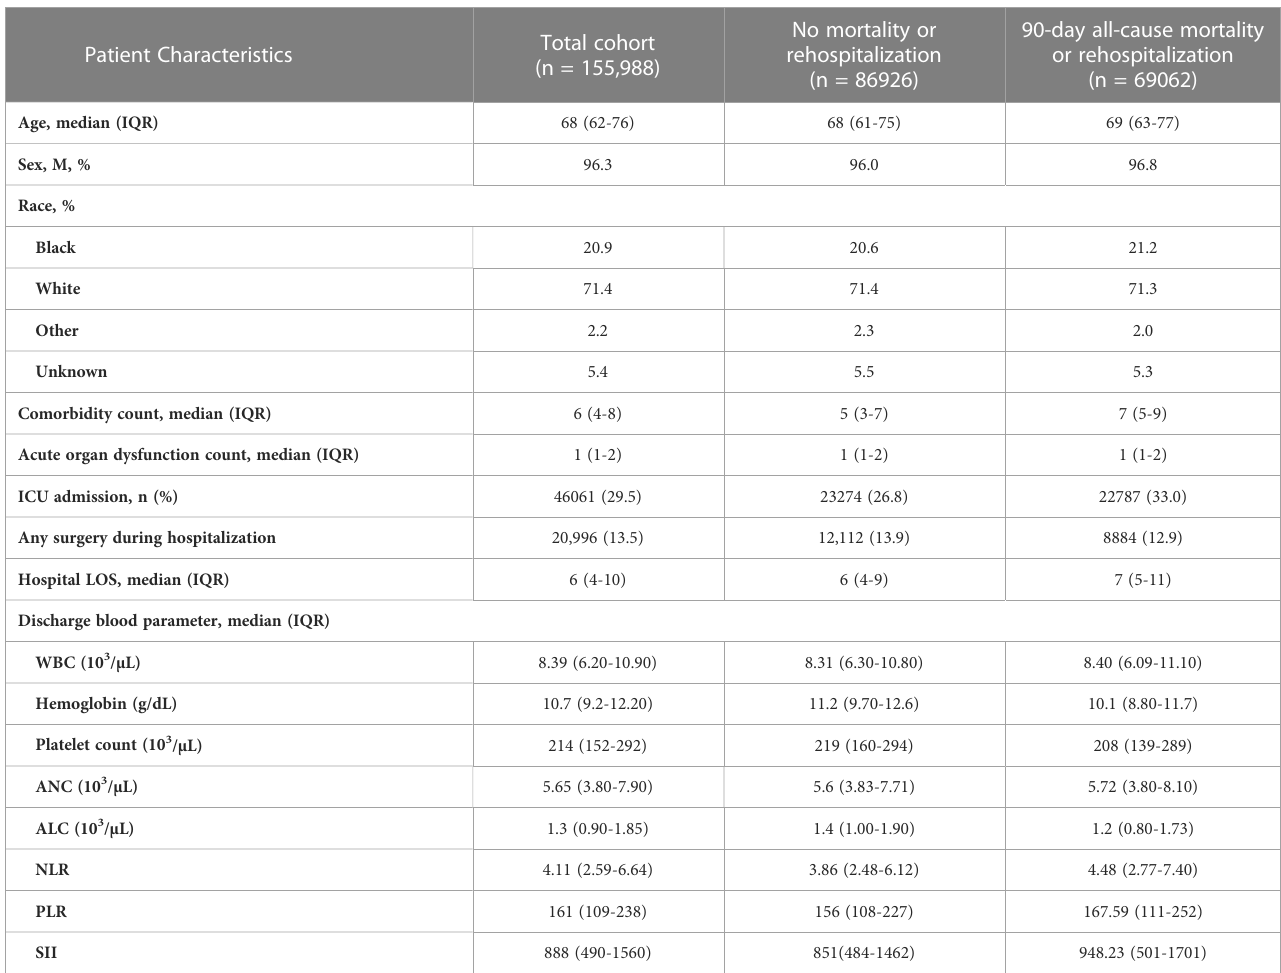
TABLE 1 Characteristics of Sepsis Cohort, strati fi ed by composite outcome.